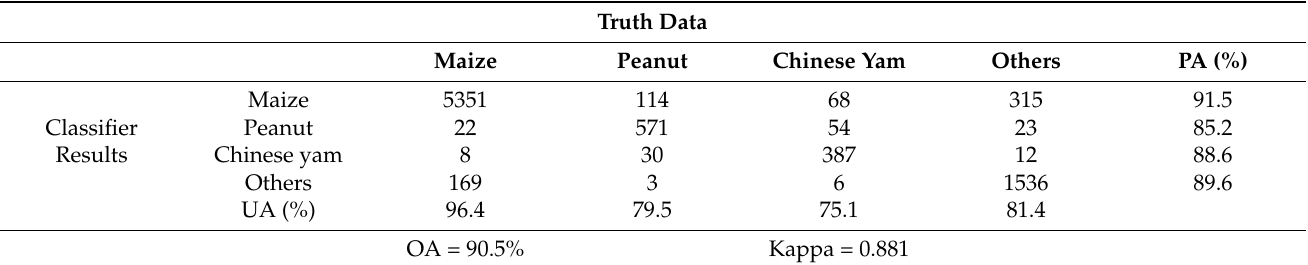
Table 7. Confusion matrix of fused multi-temporal Sentinel-1 and -2 data. The value displayed for each class is the number of pixels.